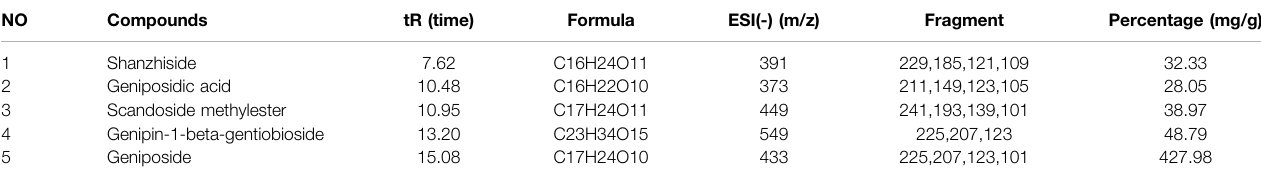
TABLE 1 | Quantitative analysis indicated fi ve active compounds in the GJ-IF.